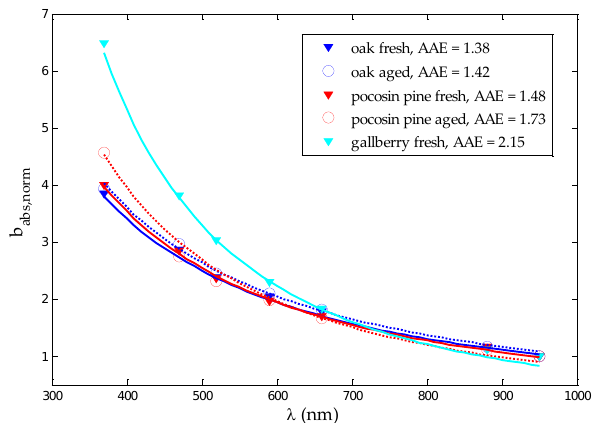
Fig. 2. Absorption coefficients of fresh and aged emissions mea- sured using the Aethalometer normalized by absorption coefficient values at 950nm. Solid lines are power-law fits with AAE values given in the